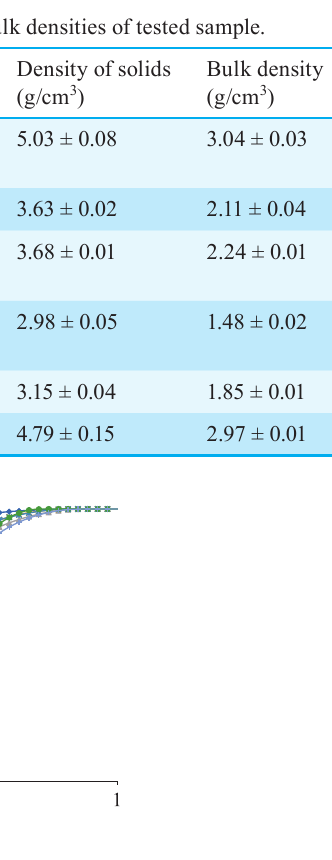
Fig. 2 Particle size distribution of grinding test feed samples.